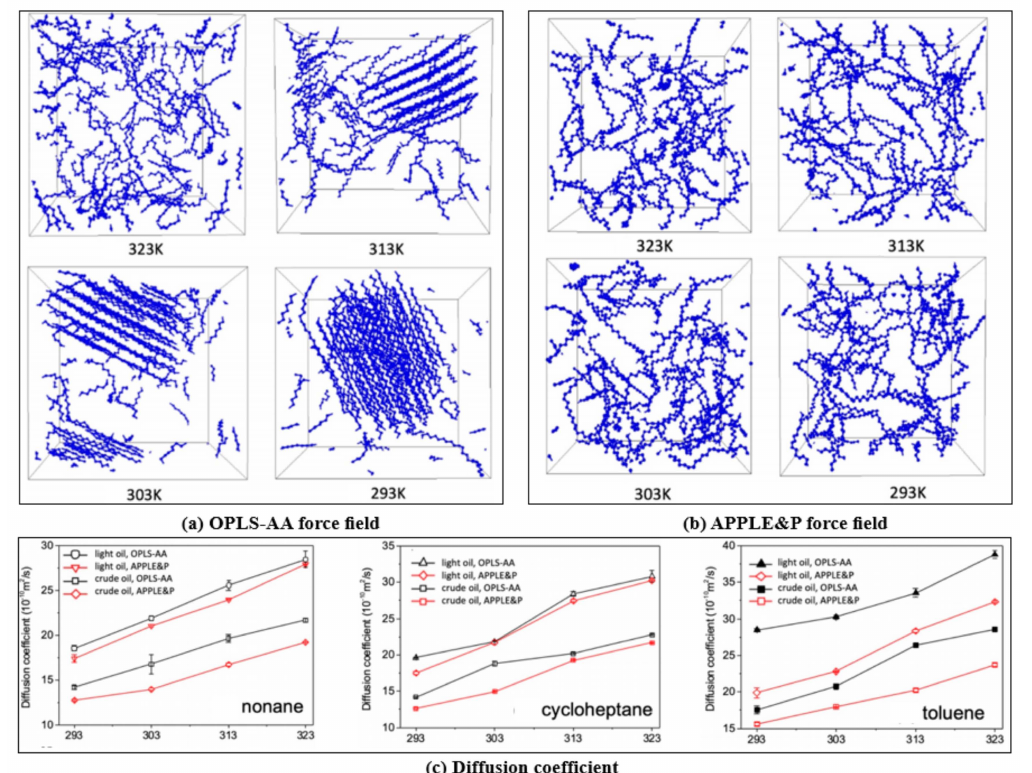
Figure 10. Configurations and self-diffusion coefficients of wax molecules from simulations with the OPLS-AA and APPLE&P force field. ( a ) simulation configuration of wax molecules at different temperatures based on OPLS-AA force field, ( b ) simulation configuration of wax molecules at different temperatures based on APPLE&P force field and ( c ) temperature dependence of diffusion coefficients of representative small molecules [120].